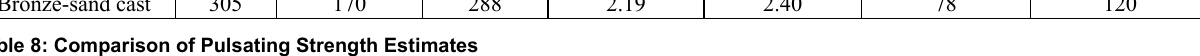
Table 8: Comparison of Pulsating Strength Estimates Pulsating Strengths at 99% Reliability (MPa) Material Bronze-sand cast Table 9a: Pulsating Strengths from Other Sources with endurance strength factor of 70% Material Gray cast iron Bronze-sand cast Table 9b: Pulsating Strengths from Other Sources with endurance strength factor of 63%